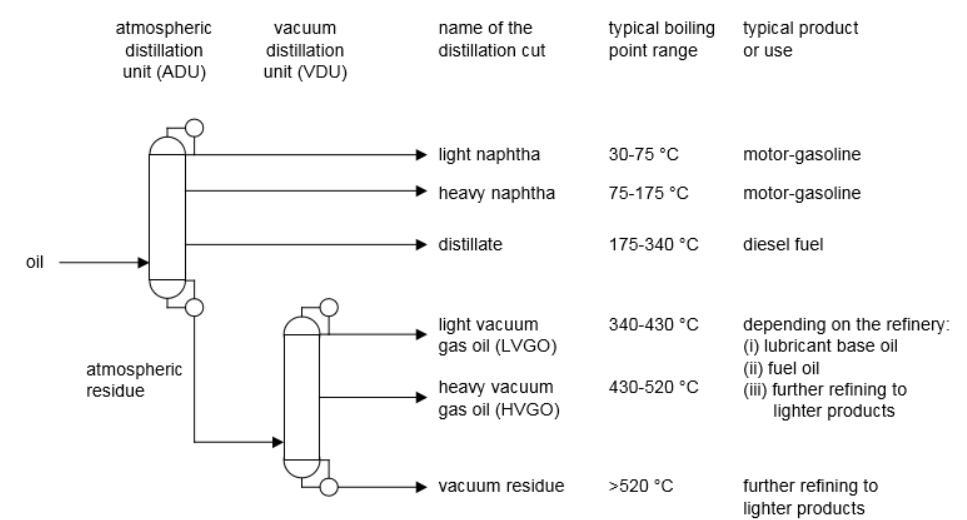
Table 1. Zeolite framework types and properties relevant to fuels refining processes. Framework Type